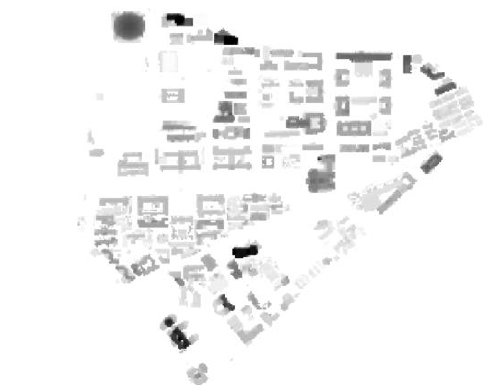
Figure 18. Raster data made from the original LiDAR data